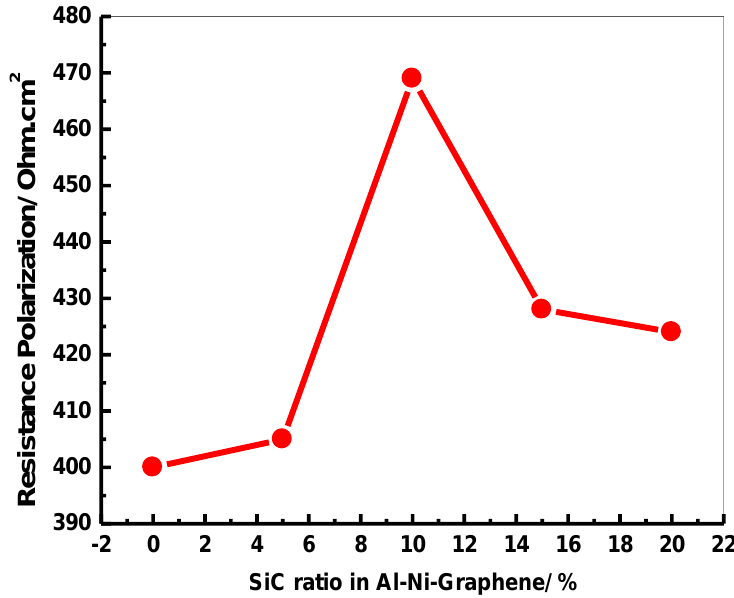
Figure 12. Variation in ohmic resistance polarization with different SiC weight percentages in the Al-Ni-Gr substrate for ZnO film.